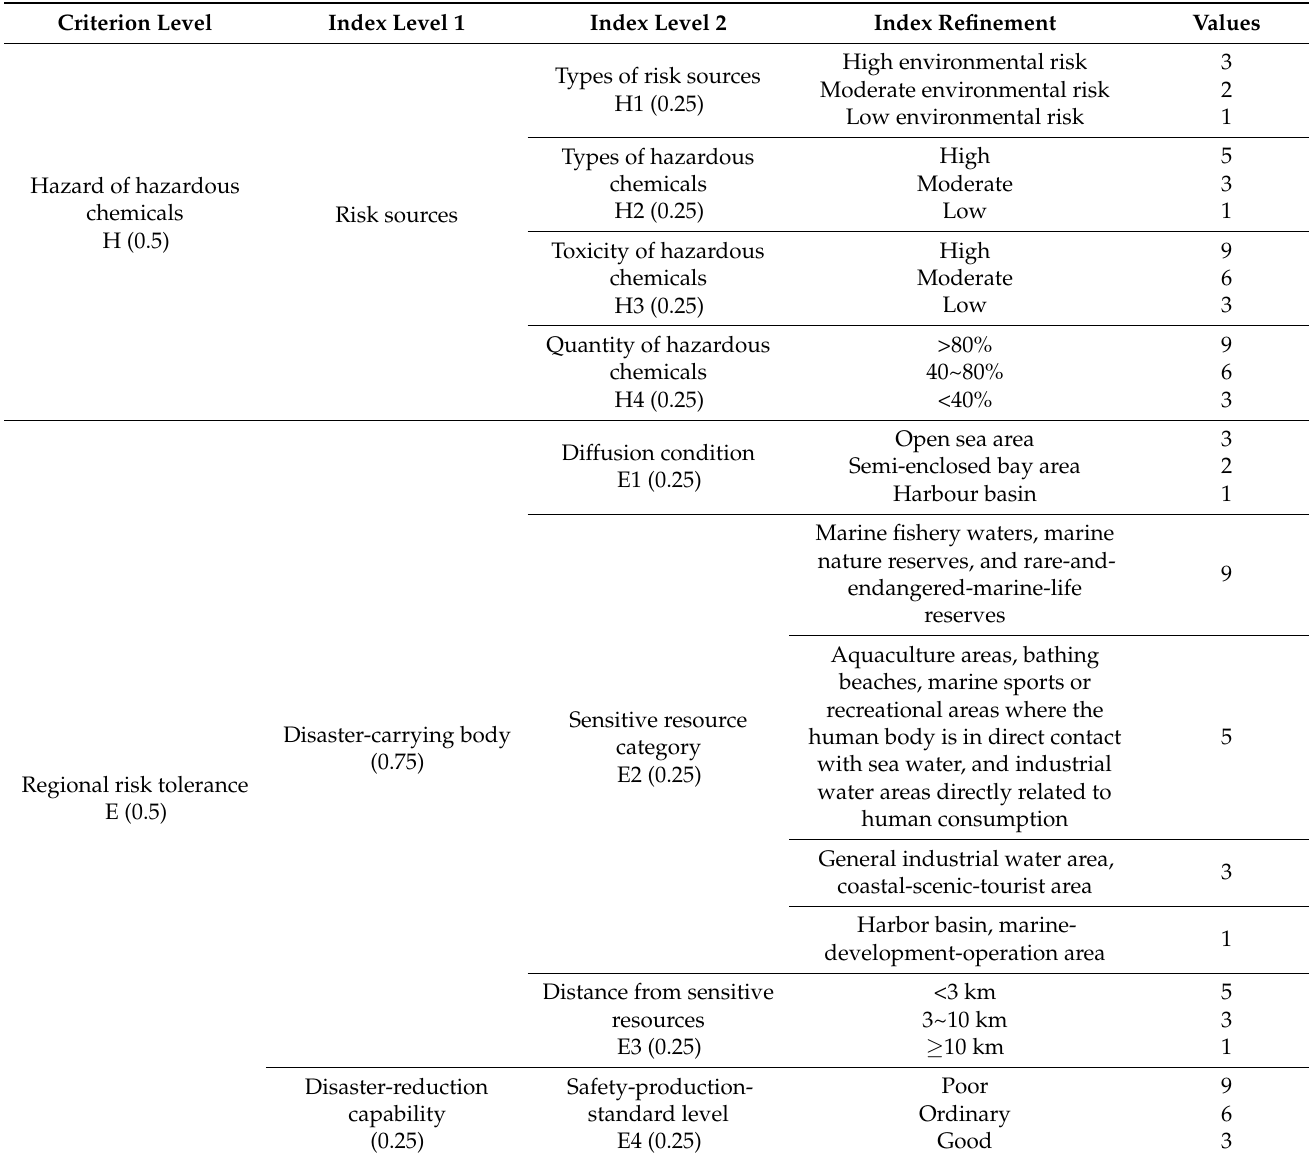
Table 2. Classification values for risk assessment of hazardous chemicals leaking into the sea.